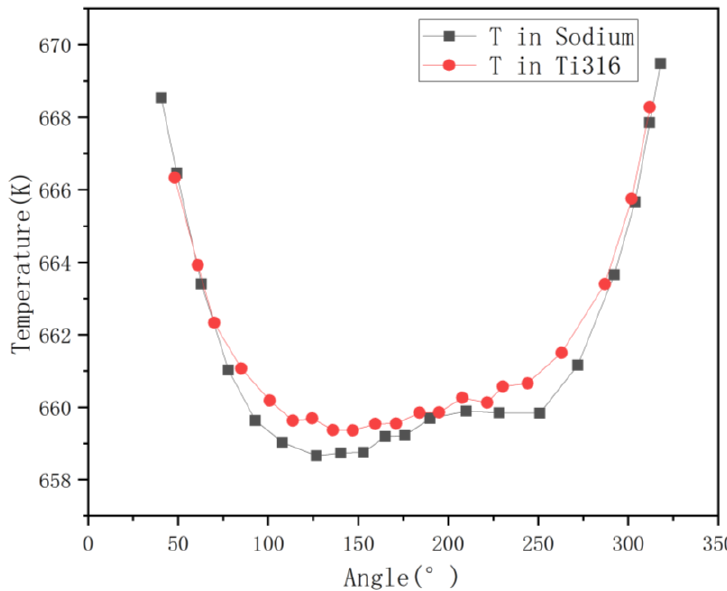
Figure 10. Temperature curves of sodium and wrapping wire around the wrapping wire.